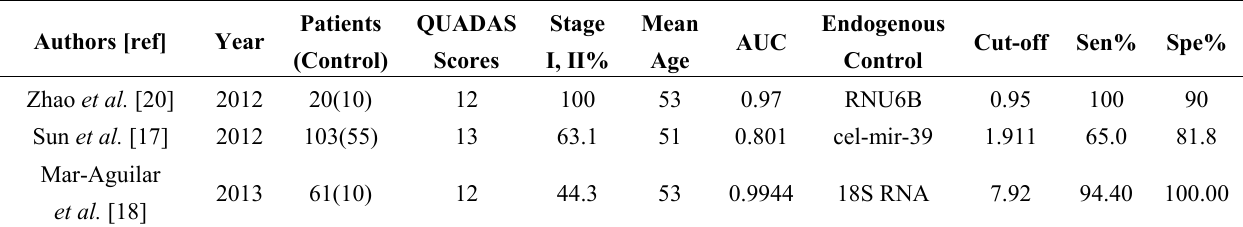
Table 1. Summary of studies using miR-155 as a biomarker of BC and study quality